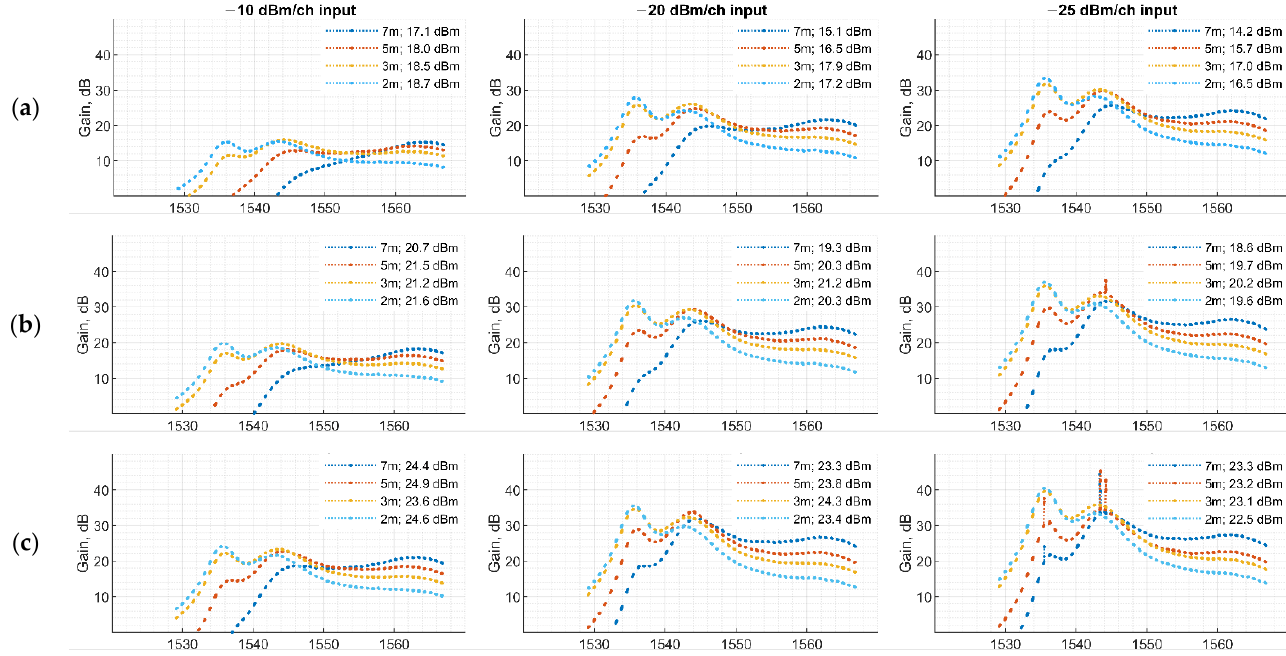
Figure 10. Experimentally determined EYDFA gain at three different input signal powers vs. EYDF length and pump power of ( a ) 0.6 W, ( b ) 1 W, ( c ) 2 W. Legend on each graph shows fiber length and total output power.